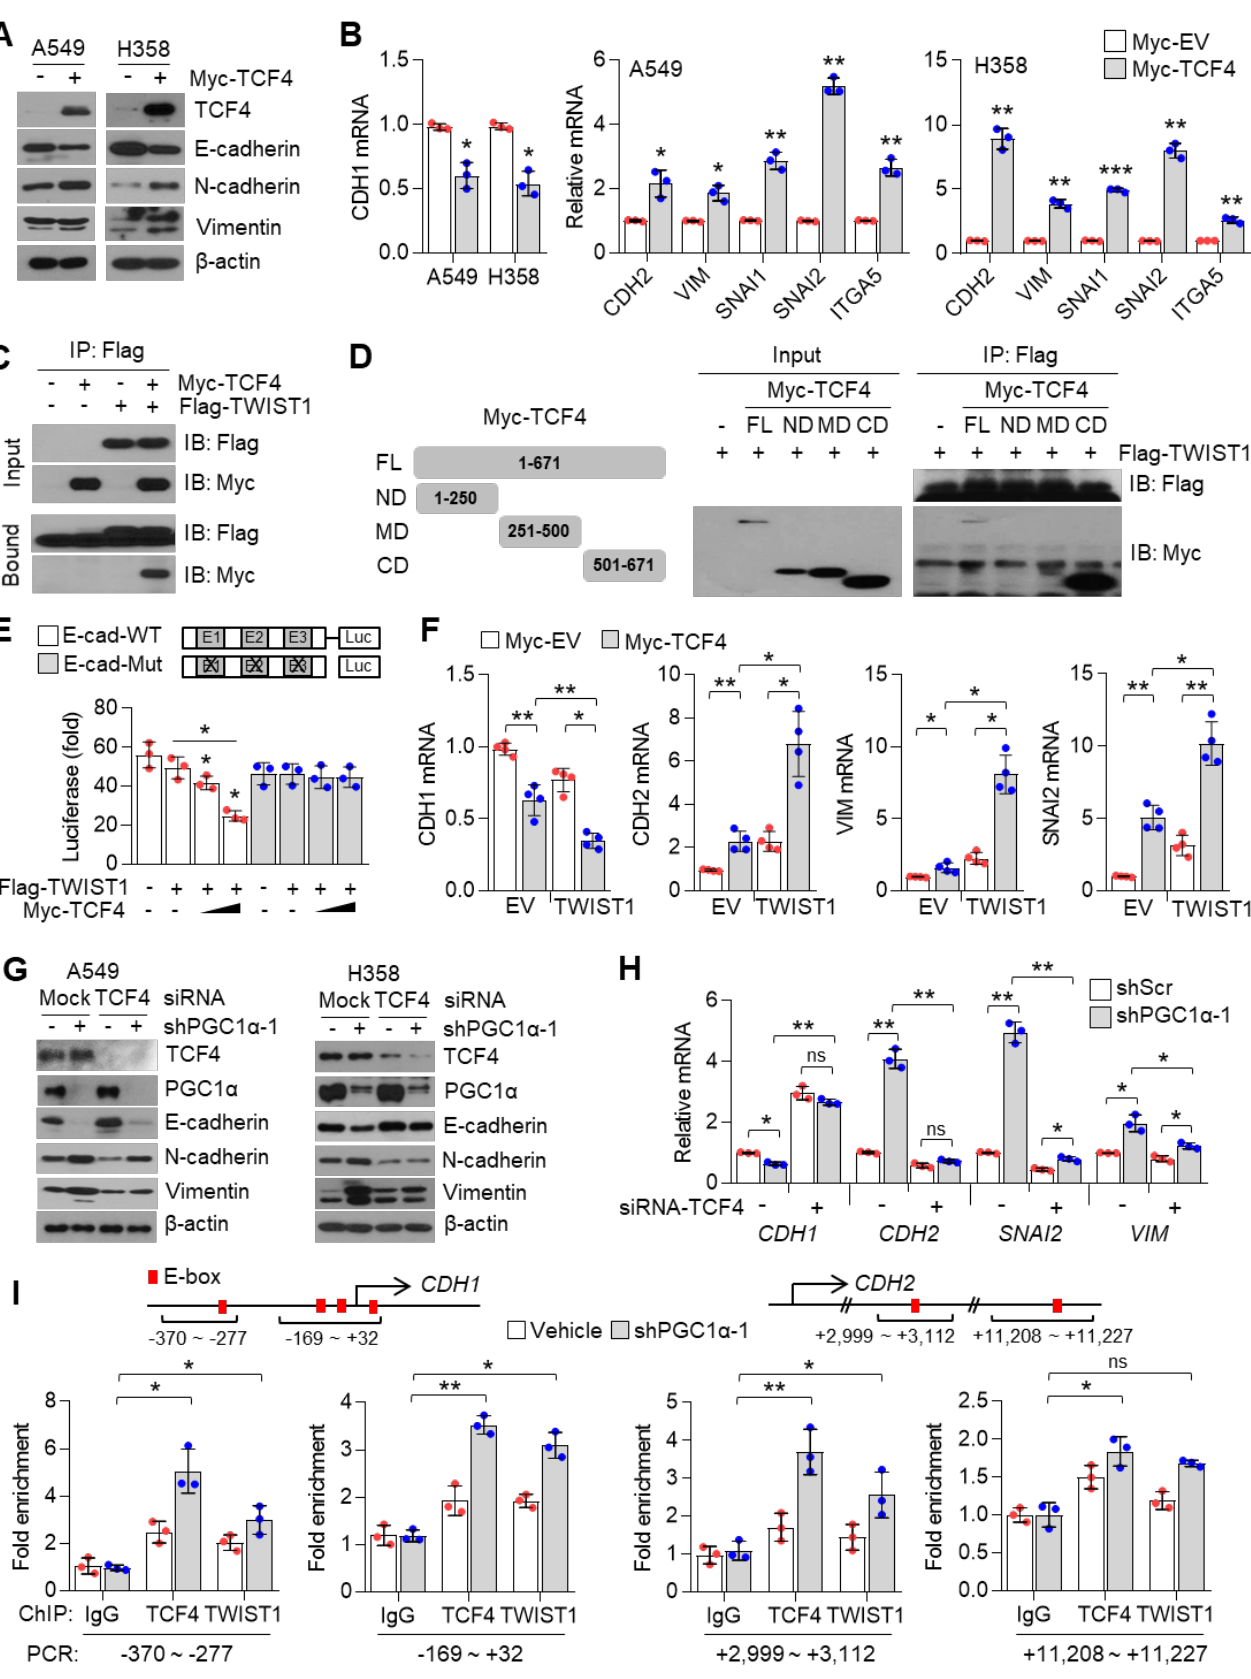
Figure 6. TCF4 promotes EMT by cooperating with TWIST1. ( A ) Western blots of indicated proteins. ( B ) Expression of the EMT genes ( n = 3). ( C ) Interaction of TCF4 and TWIST1. ( D ) Binding domain of TCF4 and TWIST1. Myc-TCF4 and its mutants (FL, Full length; ND, N-terminal domain; MD, Middle domain; CD, C-terminal domain) were transfected into HEK293T cells with Flag-TWIST1 as indicated, and the interaction between TCF4 and TWIST1 was analyzed using co- immunoprecipitation and Western blotting. ( E ) E-cadherin-wild type and -mutant promoter luciferase analysis ( n = 3). ( F ) Expression of the EMT genes in cells expressing pLX304-V5-GFP or pLX304-V5-TWIST1 in the control and Myc-TCF4 transfected A549 cells ( n = 4). ( G ) Western blots of indicated proteins. ( H ) EMT genes expression in A549 cells ( n = 3). ( I ) ChIP for TCF4, TWIST1, and IgG, followed by ChIP-qPCR in the control or in PGC1α-silenced A549 cells confirms the binding of TCF4 and TWIST1 on the CDH1 or CDH2 promoter loci ( n = 3). Values represent mean ± SD. ns, not significant; * p < 0.05, ** p < 0.01, and *** p < 0.001 by Student’s t -test. The whole western blot images are showed in Figure S7. 3.7. ID1 Attenuates EMT by Interfering with the TCF4-TWIST1 Interaction ID1 is an endogenous inhibitor of E-protein, and consequently dissociates the inter- action between E-protein and bHLH transcription factor on the E-box containing pro- moter [30]. In addition, ID1 is predominantly expressed in lung cancer cells and is directly regulated by PGC1α at the transcriptional level (Figure 4). Thus, we speculated whether ID1 acted as an inhibitor of TCF4 and TWIST1 during EMT induced by PGC1α loss. It was observed that ID1 strongly interacts with TCF4 (Figure 7A), and this interaction occurs particularly in the c-terminal domain of TCF4, where it shares an interaction with TWIST1 (Figure 7B). Consistent with the mechanistic function of ID1, the interaction between TCF4